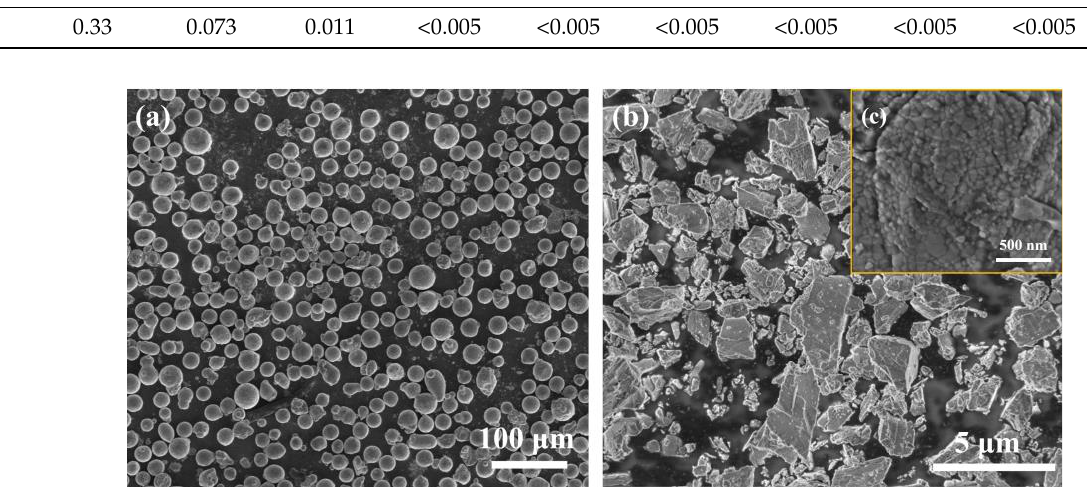
Figure 1. SEM images of ( a ) AlSi10Mg powder, ( b ) Y 2 O 3 clustered powder, and ( c ) nano Y 2 O 3 particles that form the clustered powder.